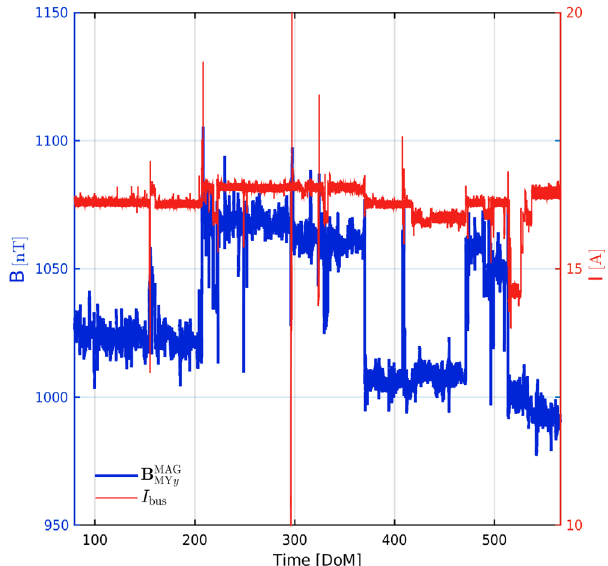
Figure 5. LPF magnetic fi eld measured by theMYmagnetometer along the LTP y -axis (blue) and main bus current (red). The two physical quantities appear correlated and show common sudden changes.